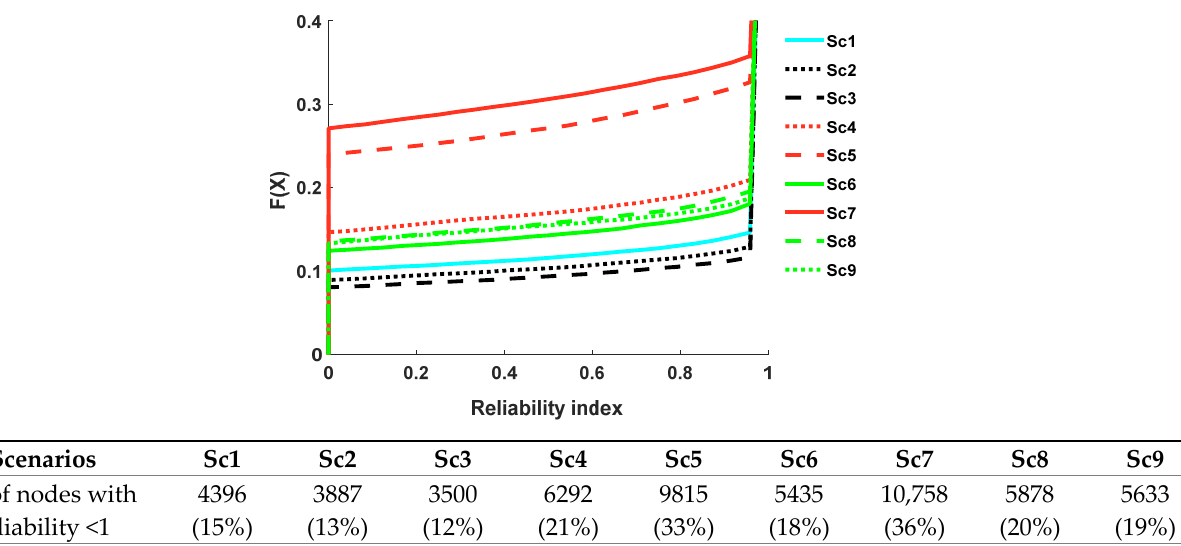
Figure 2. Distribution of nodal minimum chlorine residuals in Sc1 to Sc8, for all nodes in the network that were categorized based on their daily minimum chlorine concentration under the current scenario (Sc1); Median; Box: 25–75%; Whisker: 10–90%.